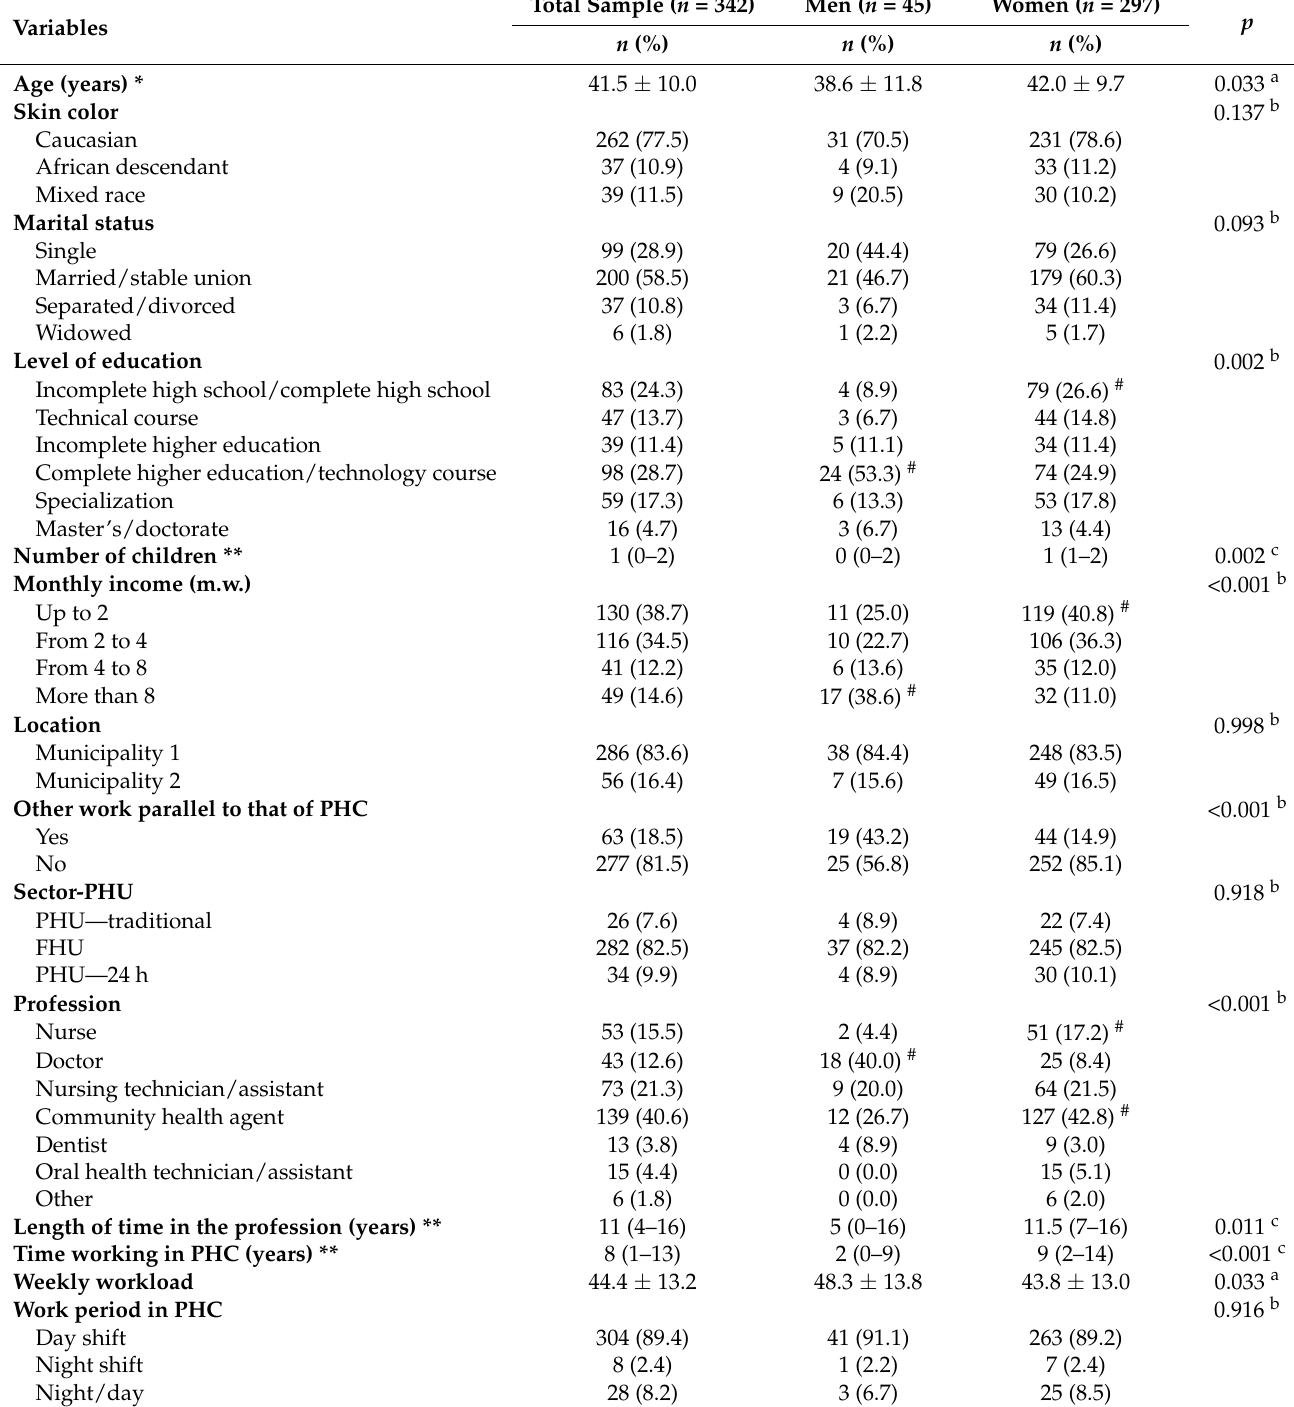
Table 1. Characterization of the total sample according to the gender of the health care